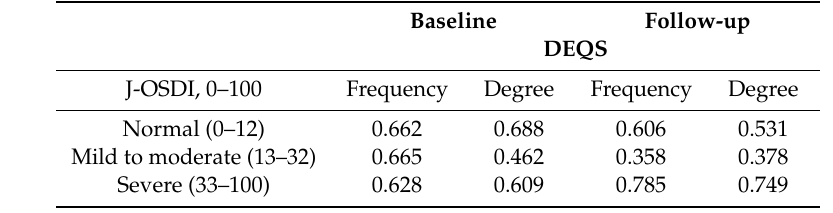
Table 2. Correlation between the J-OSDI total score and DEQS (Frequency and Degree) based on the J-OSDI subgroups at baseline.